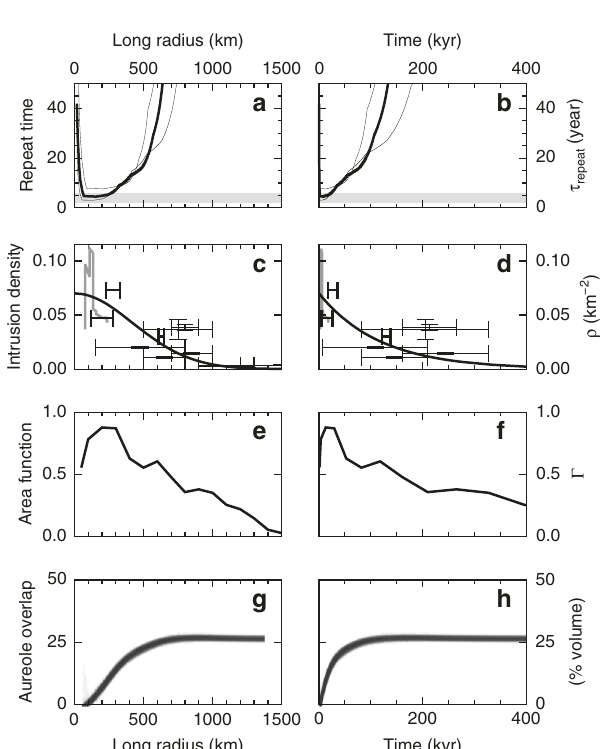
Fig. 7 Solid earth controls on onset and decay of carbon emissions. a , b Time between successive sill intrusions ( τ repeat ) as a function of long radius of the underlying mantle thermal anomaly ( a ) and of time ( b ), used for the simulations in Fig. 8. Thick and thin lines show median and interquartile range of plume fl ux estimates. Horizontal grey bar shows τ repeat range required to explain PETM onset, based on the constant- τ repeat experiments (Fig. 5). c , d Crosses show observed number of sills per unit area, ρ , measured on seismic re fl ection data (thicker lines from 3D data; thinner lines from 2D data); vertical error bars show total uncertainty range in ρ (Table 2); horizontal error bars show range in radius/time corresponding to footprint of seismic survey (Fig. 6). Black curve shows smooth parameterisation of the observations, used in Fig. 8. Grey line shows alternative ρ distribution inferred from a carbon sink-derived emissions estimate 5 (Methods; Supplementary Fig. 5). e , f Area function Γ that relates expansion rates of the mantle thermal anomaly (magma source) and the NAIP sill province (magma fate). Functions Γ ( r ) and ρ ( r ) control sill intrusion period according to 1/ τ = Q Γ ( R ) ρ ( R ) (see Results for derivation), where Q is the mantle repeat plume area fl ux and R is the long radius of the plume head. g , h Cumulative proportion of overlapping thermal aureoles (stack of 100 stochastic